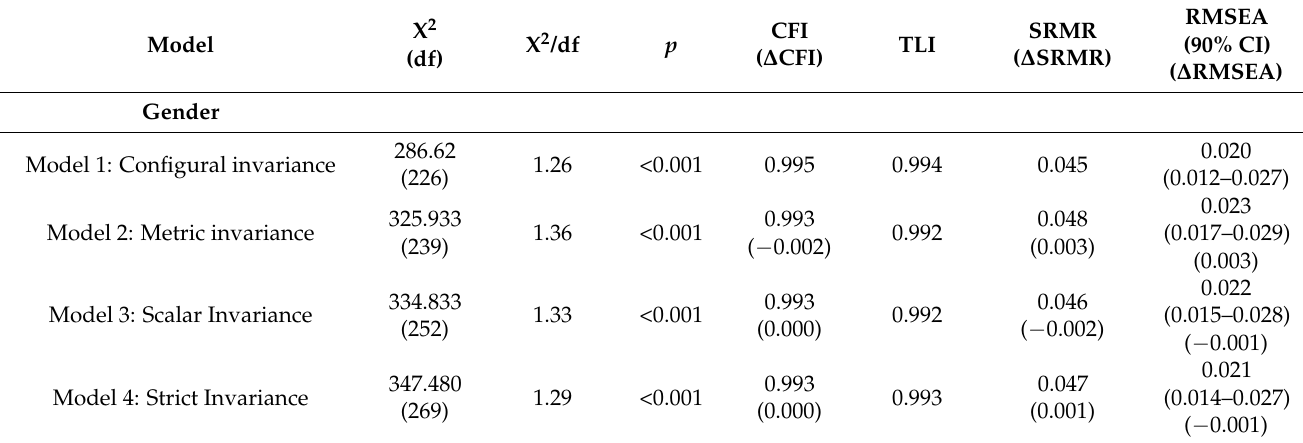
Table 7. Model fit and measurement invariance between groups according to